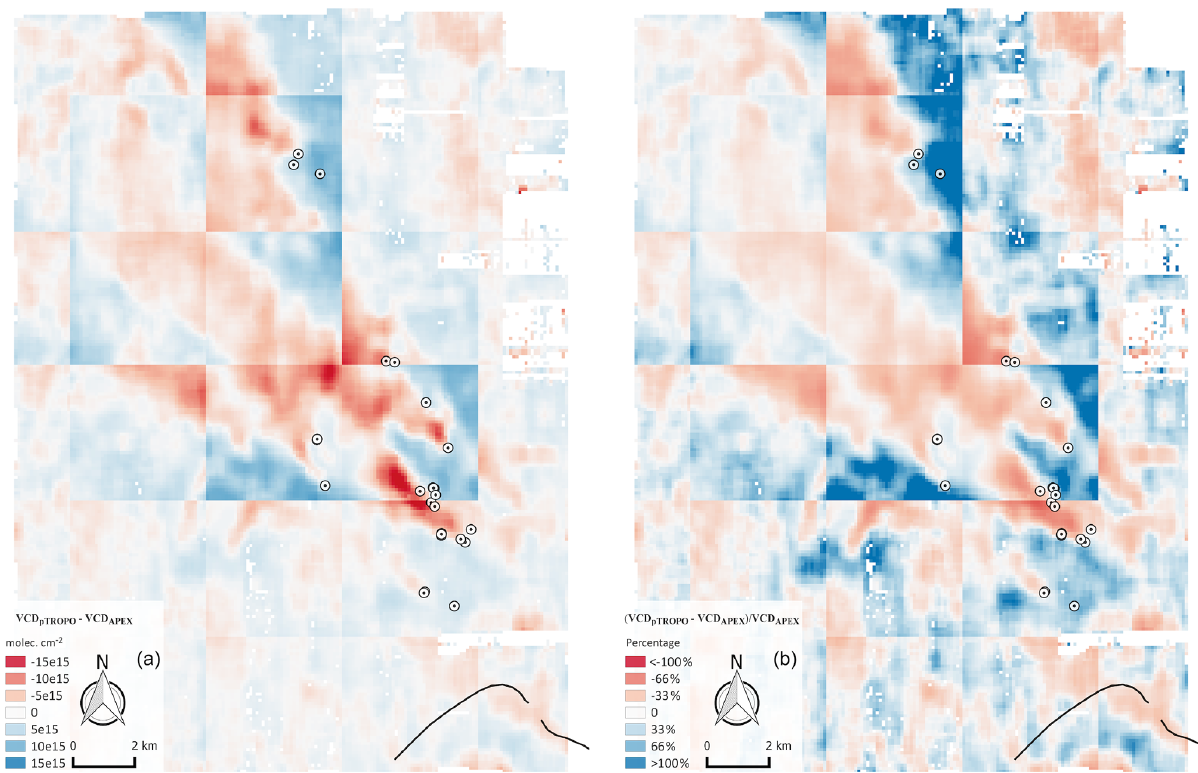
Figure 14. (a) The NO 2 VCD bias (VCD pTROPO − VCD APEX ) and (b) relative bias ((VCD pTROPO − VCD APEX ) / VCD APEX · 100) for the APEX data set acquired over Antwerp on 29 June 2019. VCD pTROPO is pseudo-TROPOMI NO 2 VCDs, constructed by averaging the APEX NO 2 VCDs within grid cells of 4.4km × 4.4km. White dots indicate the point sources, emitting more than 10kg of NO x per hour, according to the emission inventory (2017) of the Belgian Interregional Environment Agency. Part of the city ring road is indicated by the black